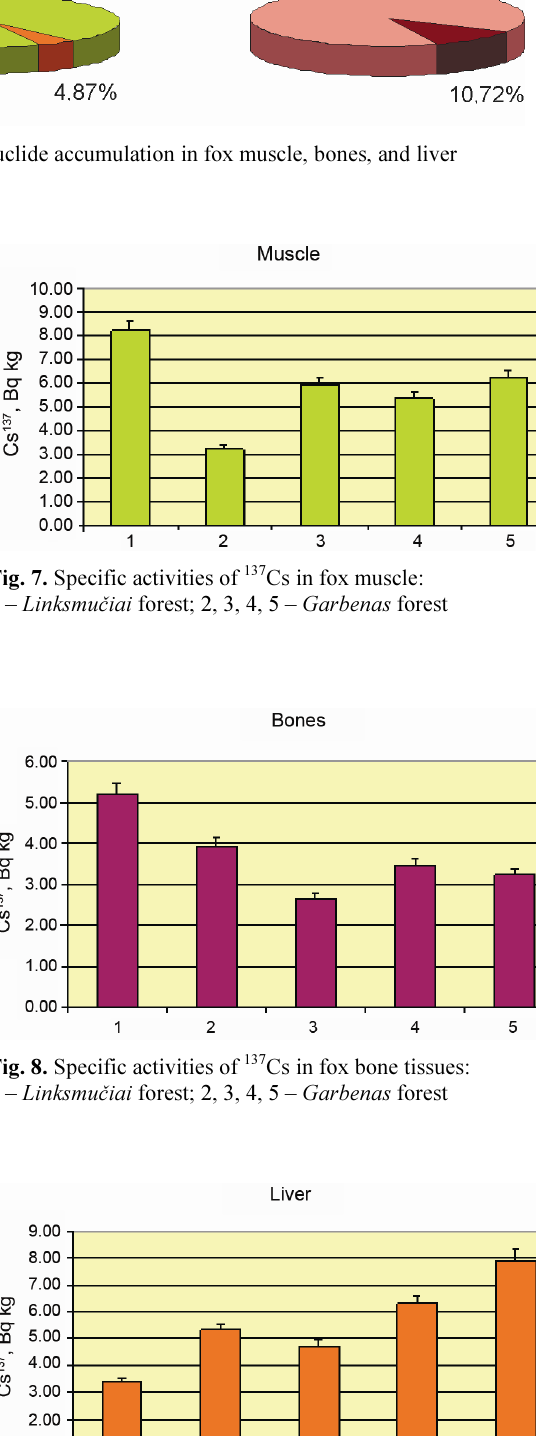
Fig. 6. Specific activities of